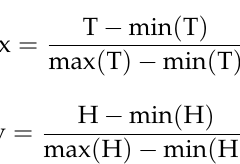
Table 1. Commonly used mathematical models of